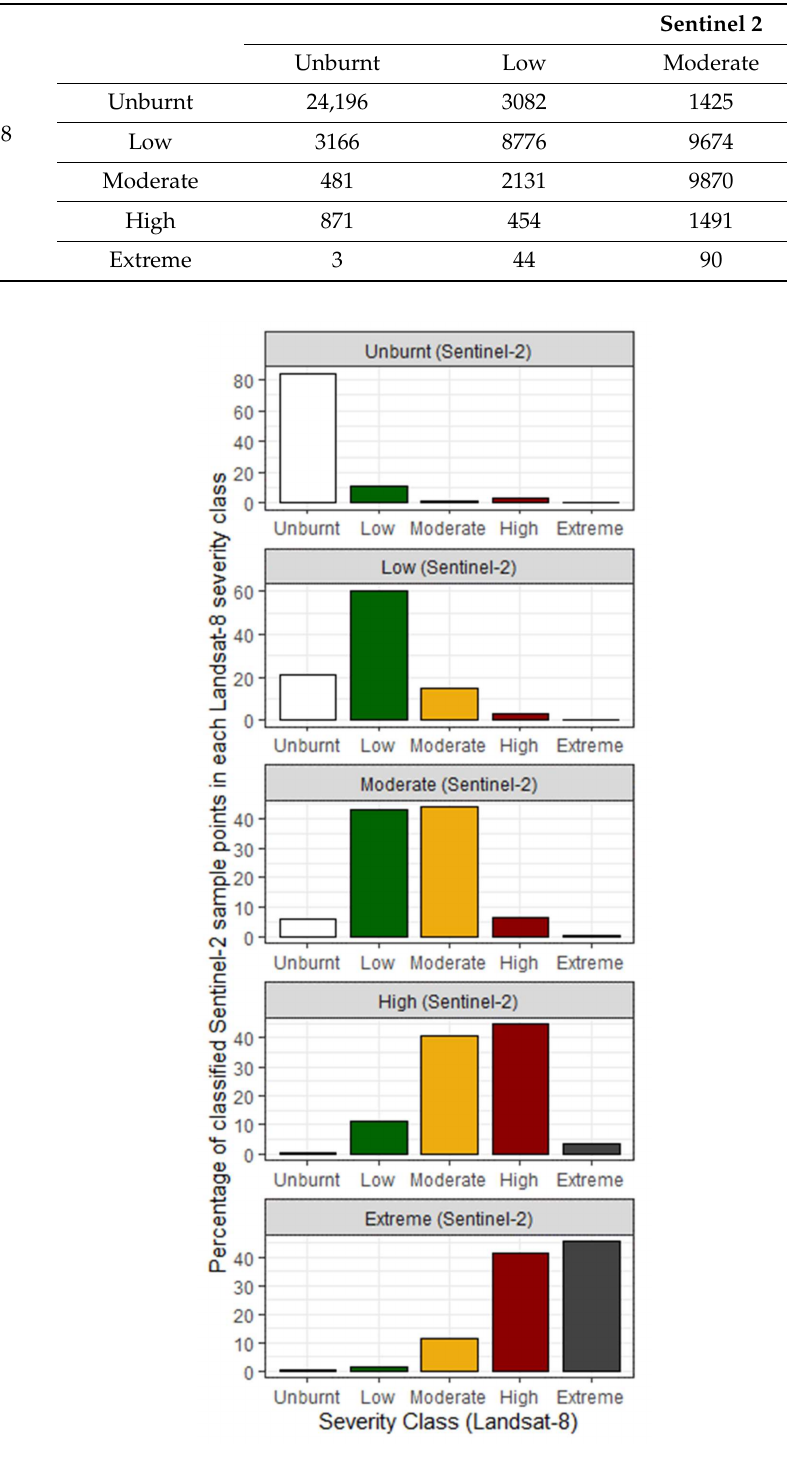
Figure 6. The percentage of Landsat 8 severity class scores within each Sentinel 2 severity class, across all random sampling